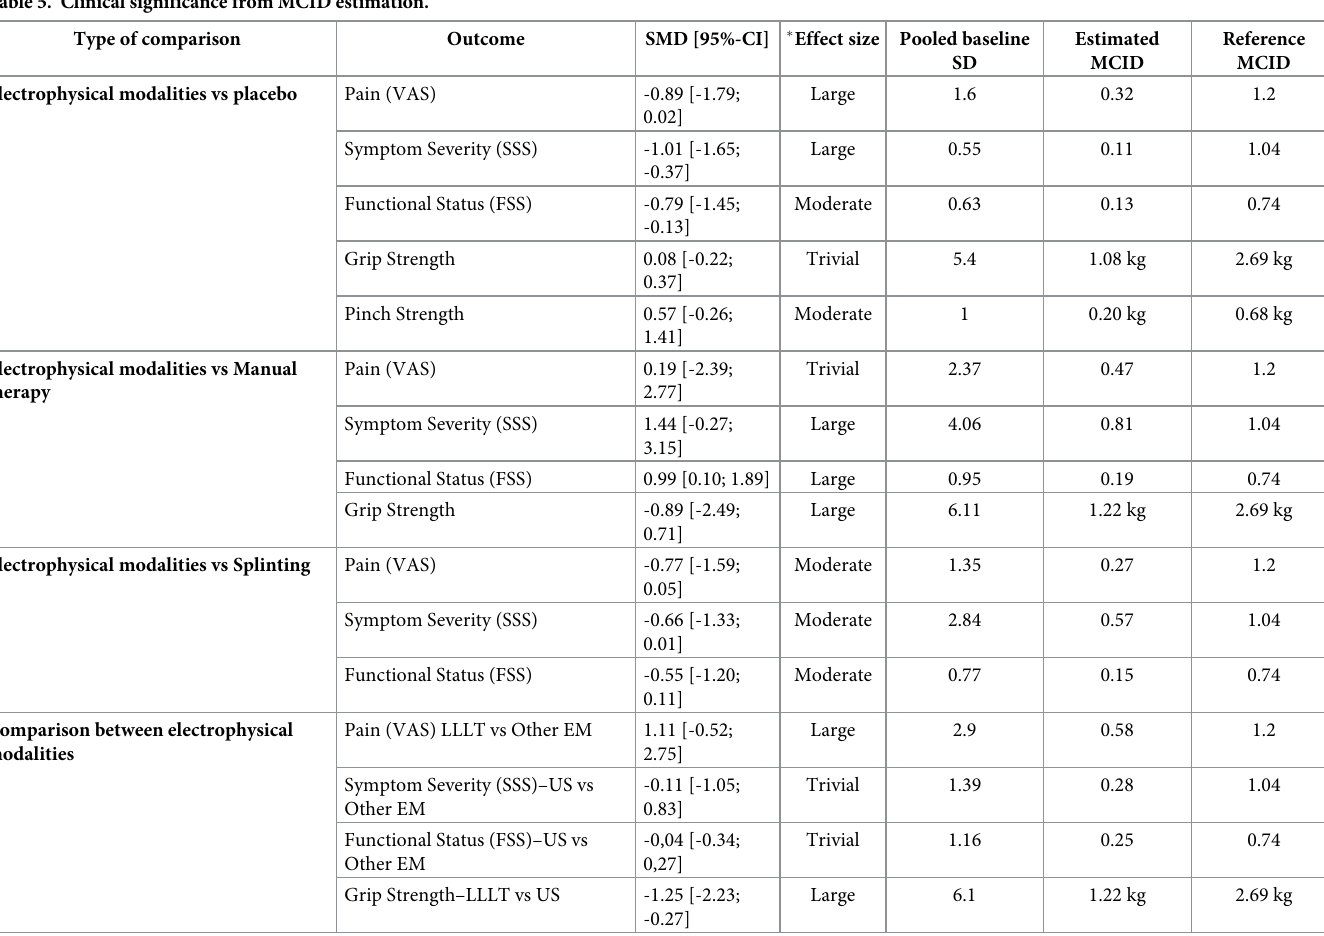
Table 5. Clinical significance from MCID estimation. Type of comparison